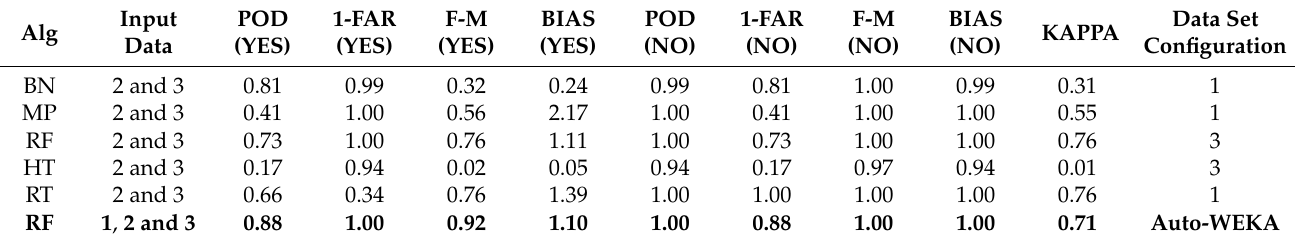
Table 8. Statistical test results of 30 min Vis forecasts ≤ 1600 m for the five algorithms (Alg) selected with input